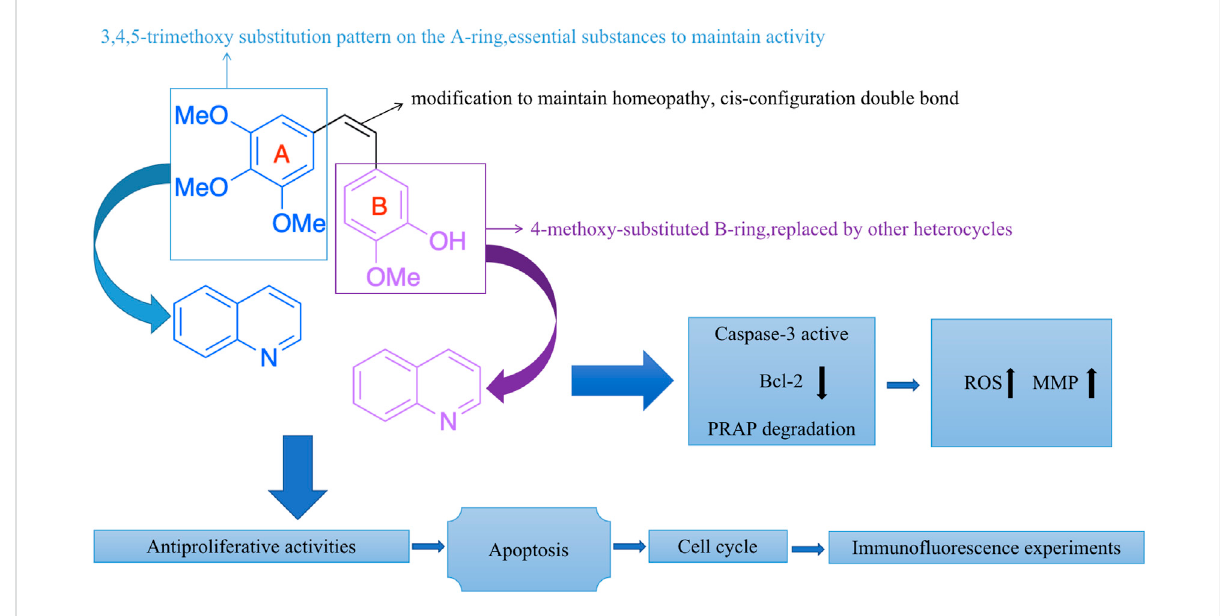
The mechanism of action of these compounds (CA-4 analogs).